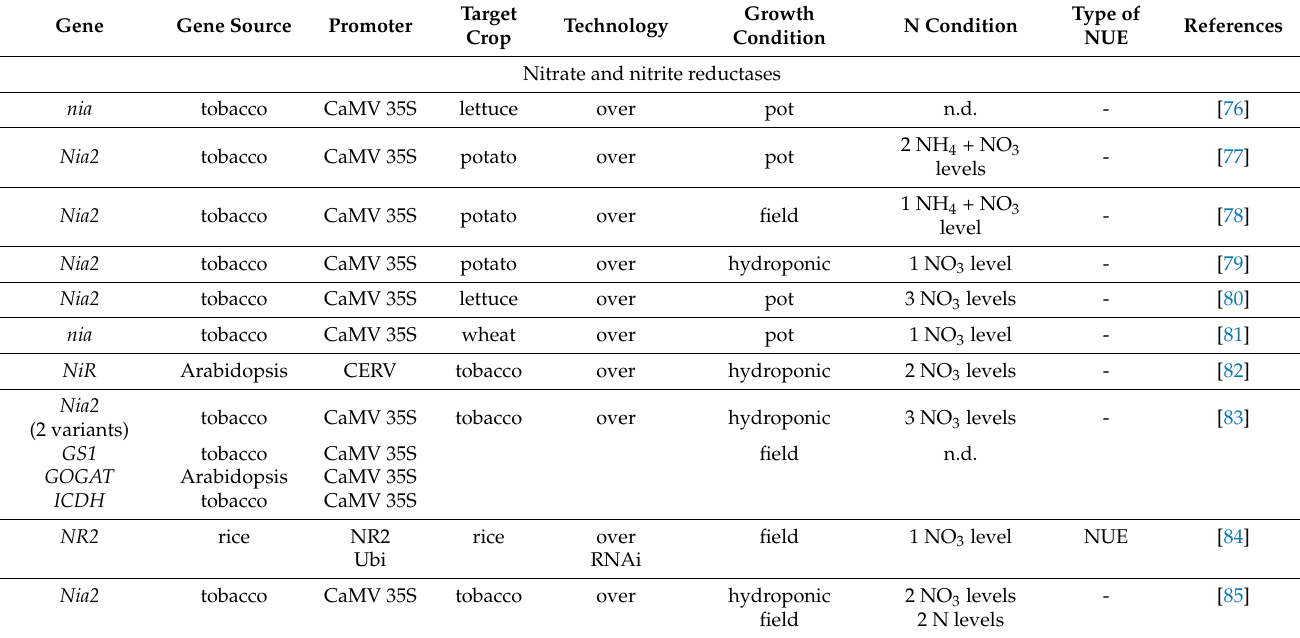
Table 2. Manipulation of nitrogen assimilation genes to improve nitrogen use efficiency in